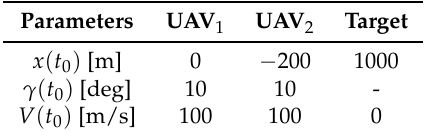
Table 1. Initial states for the numerical example.